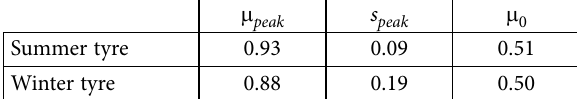
Table 6. Differences in slip referring to m peak adhesion coefficient